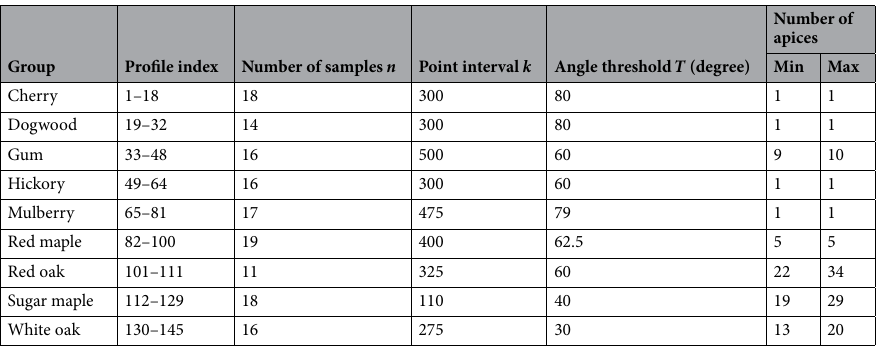
Table 4. Parameters used for identifying apices on leaf contours and the number of apices identified for each group.